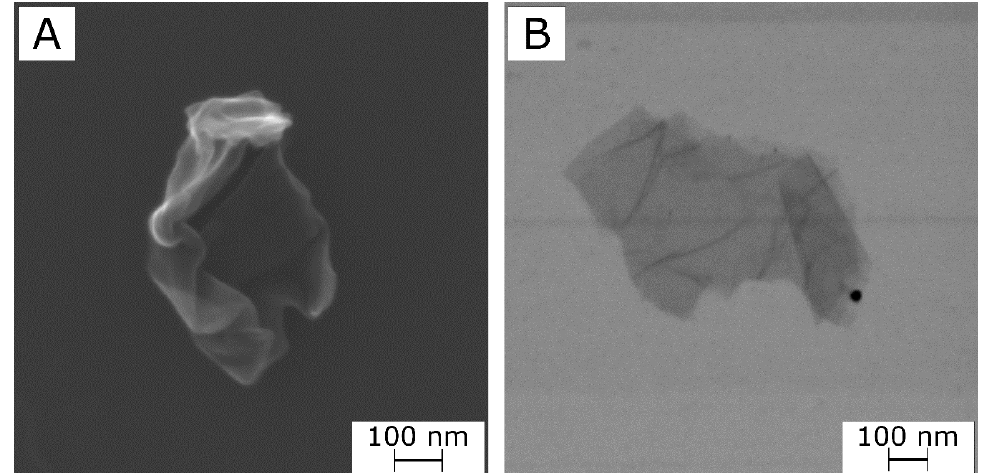
Figure 1. SEM ( A ) and STEM ( B ) micrographs of an rGO nanoplatelet.